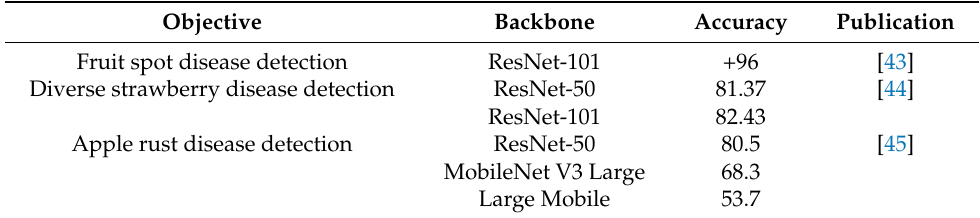
Table 2. Mask RCNN applications. Uses of Mask RCNN for plant disease